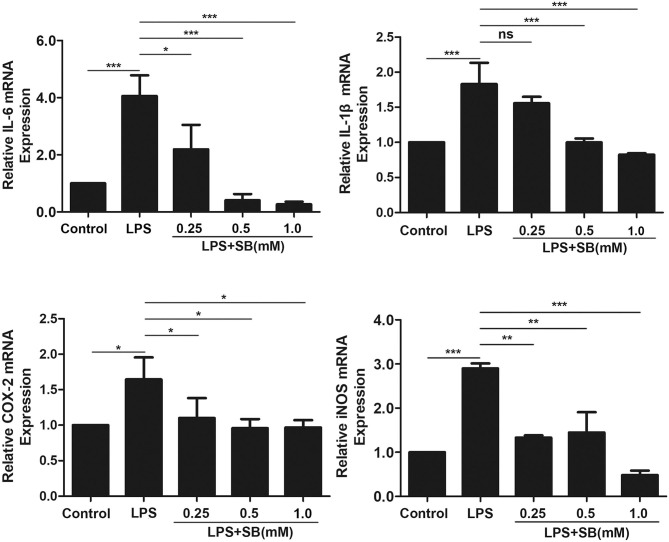
Sodium butyrate reduced gene expression of inflammatory cytokines. Bovine macrophages were pretreated with different concentrations of sodium butyrate (0.25, 0.5, 1 mM) for 12 h, and then treated with 5 μg/ml LPS for 3 h. The gene expression of IL-1β, IL-6, COX-2, and iNOS were analyzed by qRT-PCR. The gene expression levels of IL-1β, IL-6, COX-2, and iNOS are normalized to β-actin. Values were shown as means ± SD (n = 3). nsp > 0.05 meant no significance, *p < 0.05, **p < 0.01, ***p < 0.001 compared to the LPS group.